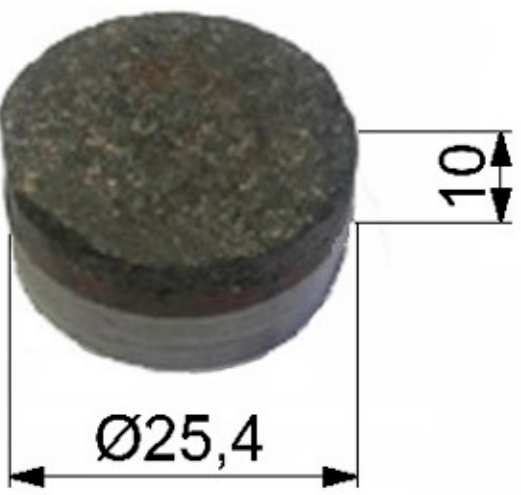
Figure 1. One of the samples used in research (mm).